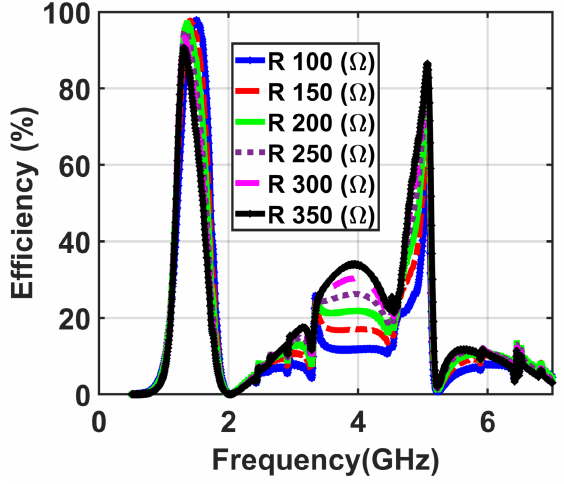
Figure 8. The obtained results demonstrating the efficiency of the presented supercell with different values of R ranging from 100 Ω to 350 Ω .